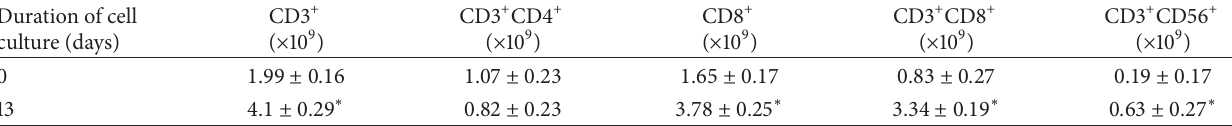
Table 2: The patients’ phenotype of peripheral blood mononuclear cells (PBMCs) before and after cell culture. Duration of cell